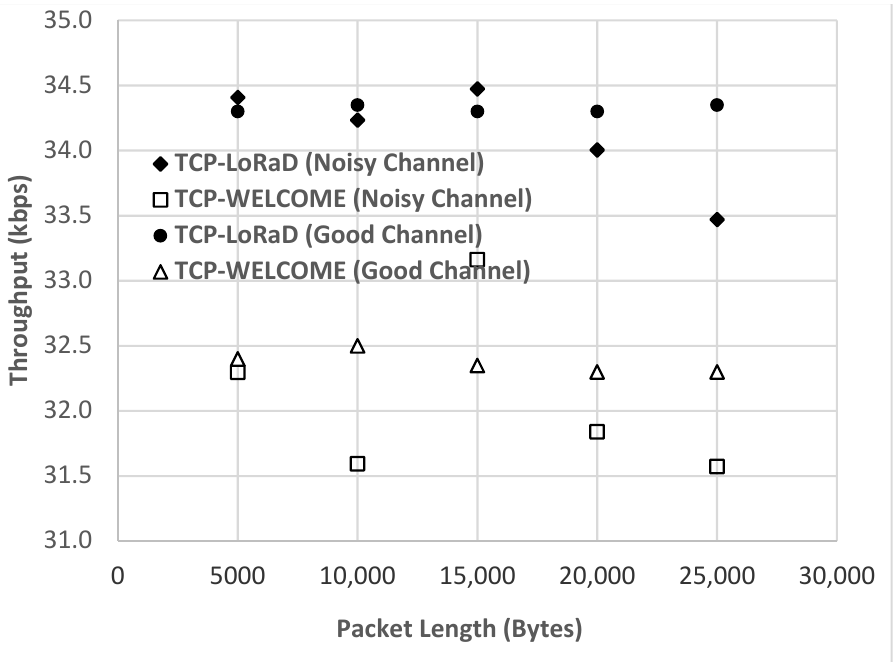
Figure 13. Throughput versus varying Packet Length in a noisy channel. Comparison of TCP-LoRaD and TCP-WELCOME.